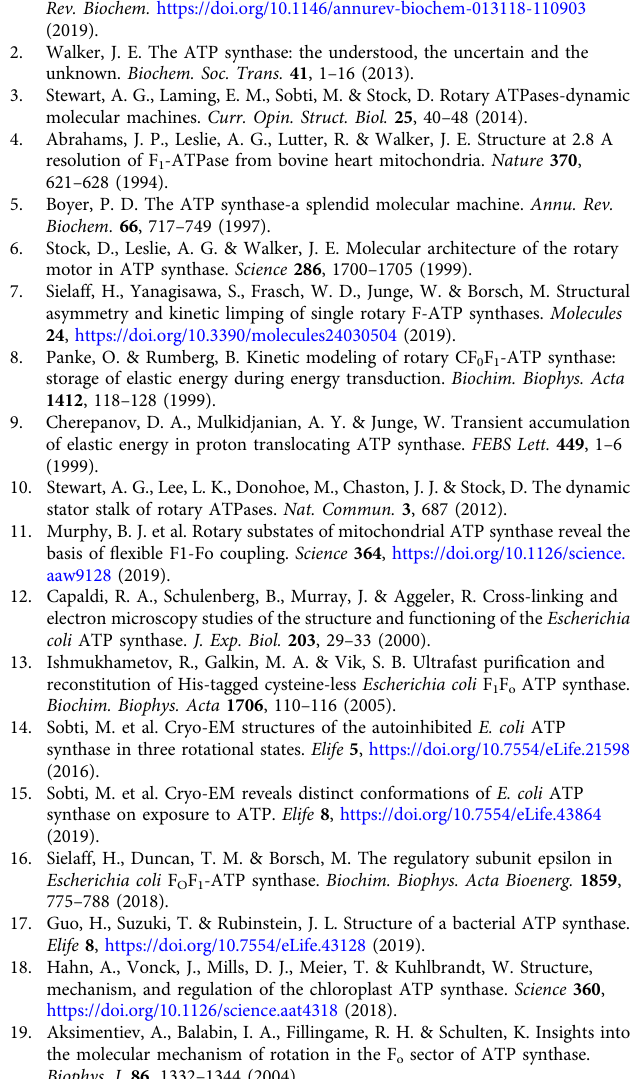
Fig. 25 for model to map FSC curves and Supplementary Table 1 for all data collection and re fi nement statistics. Mass spectrometry . Protein complexes were digested with trypsin and dried using a vacuum concentrator (SpeedVac, ThermoFisher Scienciti fi c). The co-puri fi ed lipids were resuspended in 60% acetonitrile by sonication for 10min and analyzed by LC-MS based lipidomics 24 . Brie fl y, the lipid samples were separated on a C18 column (Acclaim PepMap 100, C18, 75 µm× 15 cm; Thermo Scienti fi c) by Dionex UltiMate 3000 RSLC nano System, and then analyzed by a hybrid